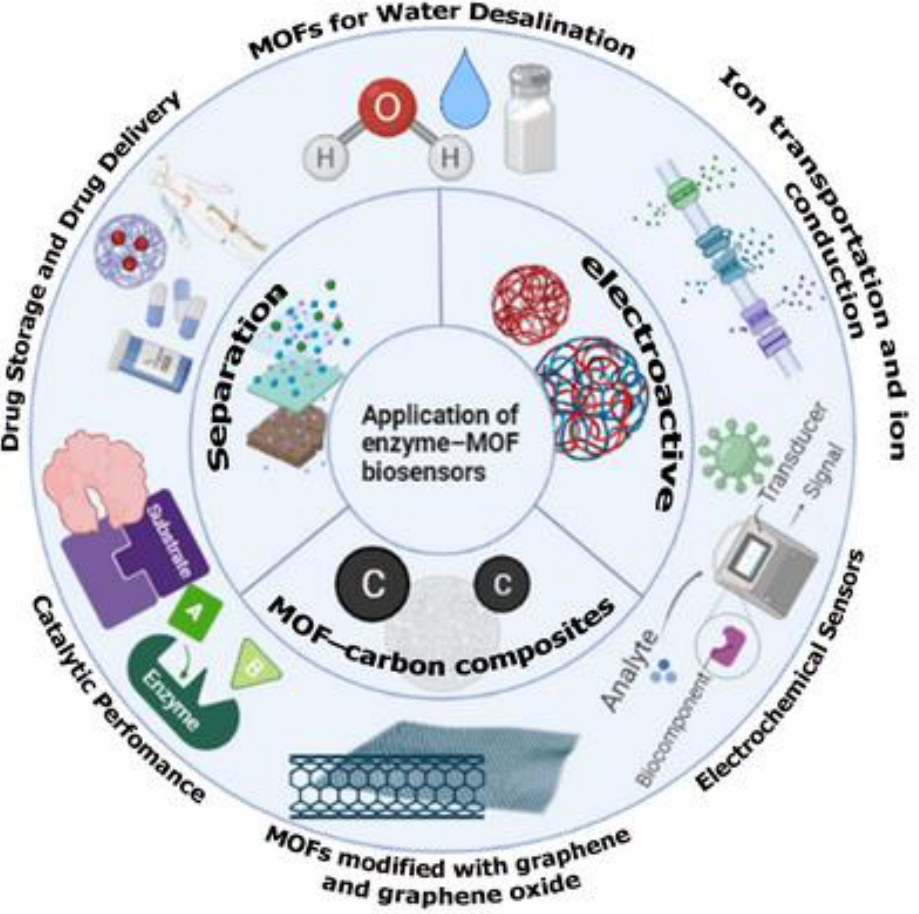
Figure 11. Applications of metal–organic frameworks in different chemical and biological areas of high interest.